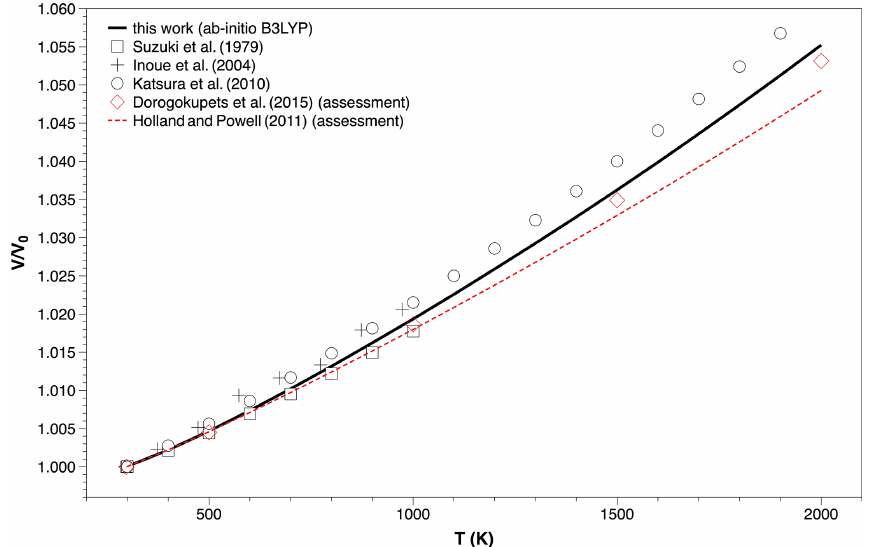
Figure 3. Ab initio B3LYP volume thermal expansion ( V/V 0 ) of Mg 2 SiO 4 ringwoodite at zero pressure, compared with experimental data (Suzuki et al., 1979; Inoue et al., 2004; Katsura et al., 2010) and thermodynamic assessments (Holland and Powell, 2011; Dorogokupets et al., 2015) at ambient pressure.